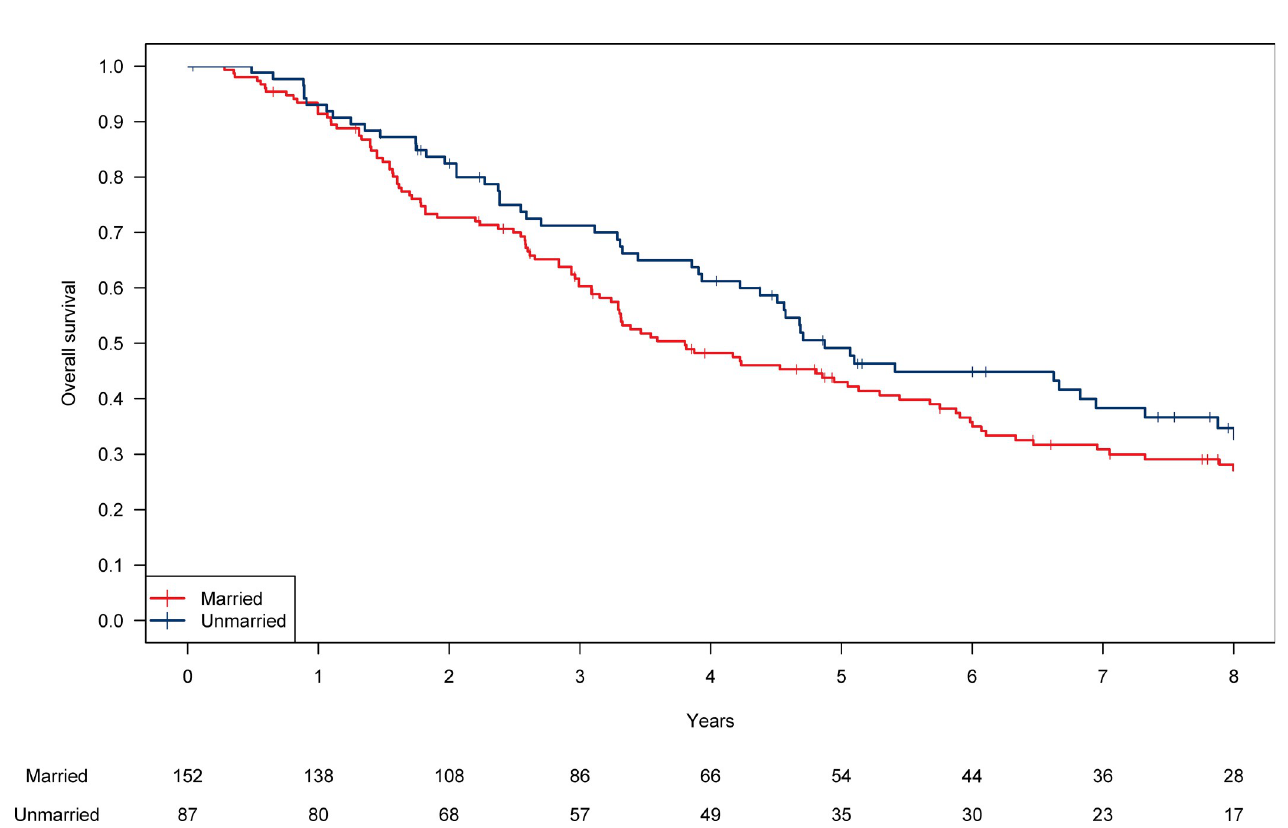
Fig 2. Kaplan-Meier curves for overall survival in the married and unmarried patients for the entire